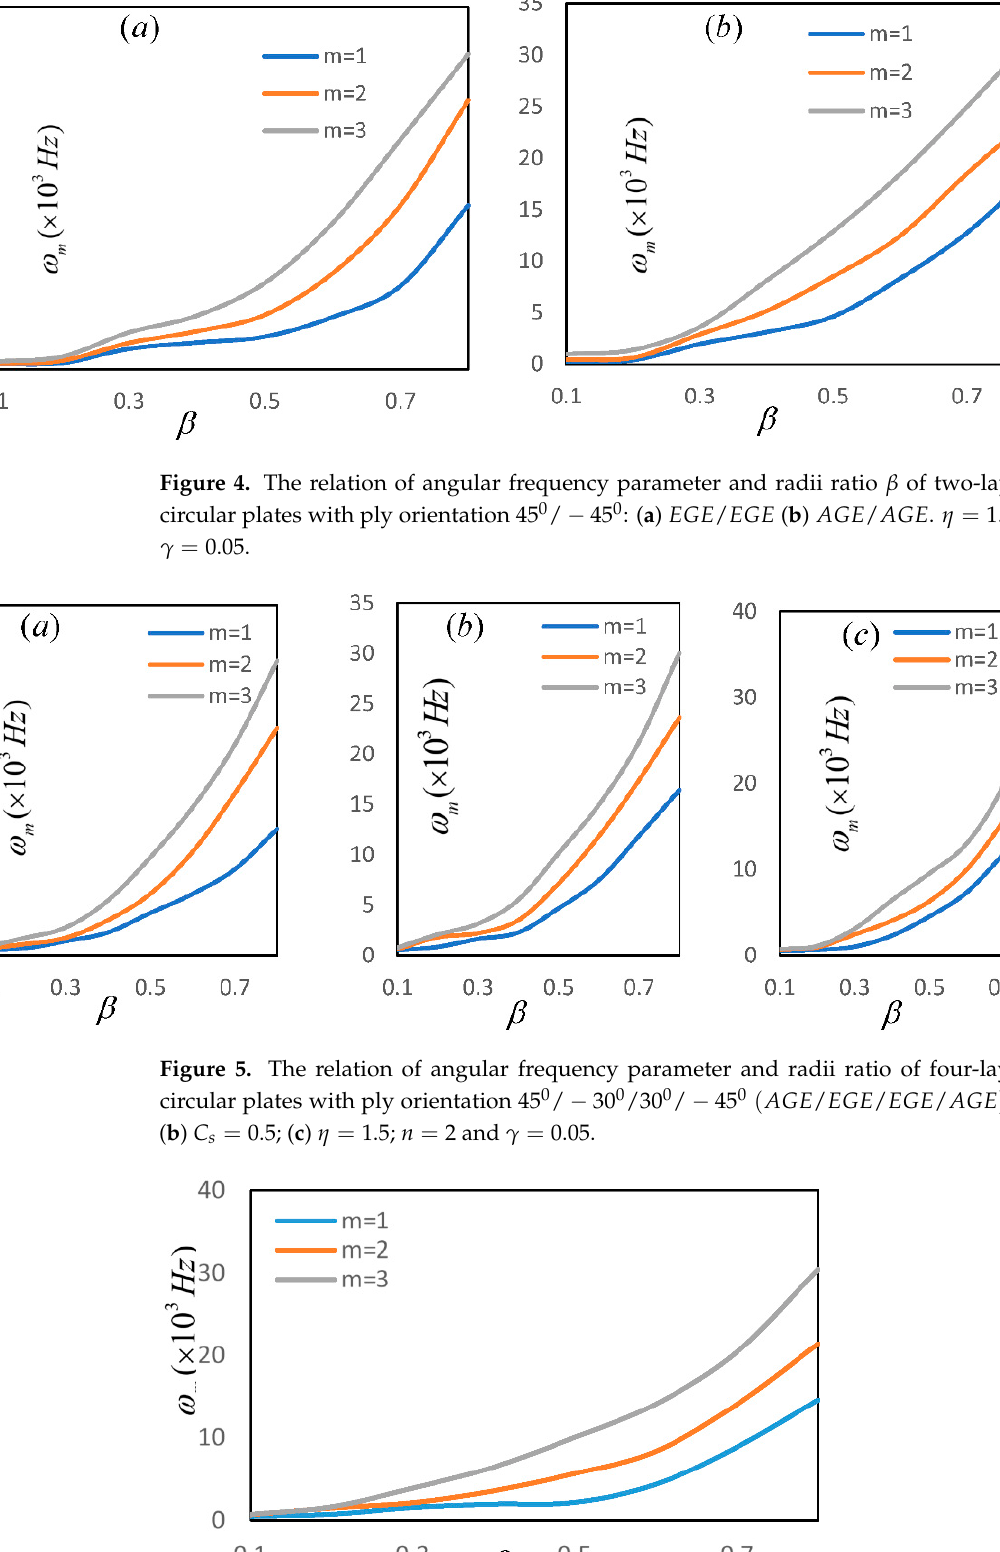
Figure 6. The relation of radii ratio and the angular frequency parameter of four-layered annular. circular plates with ply orientation 45 ◦ / − 30 ◦ /30 ◦ /45 ◦ ( KGE / EGE / EGE / KGE ) . C e = 0.2, n = 2 and γ =